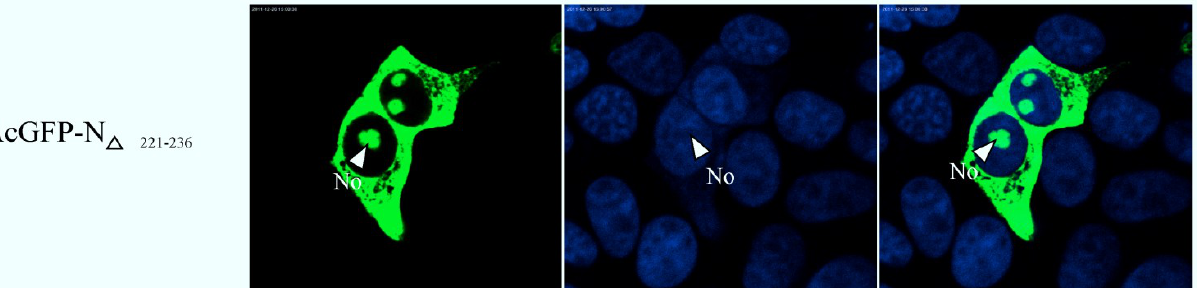
Figure 9. Confocal microscopy of the sub-cellular localization of fluorescent fusion proteins AcGFP-N . Fusion proteins are colored green and nucleus colored blue. ∆221–236 Merged images are also presented. The nucleolus (No) is arrowed where